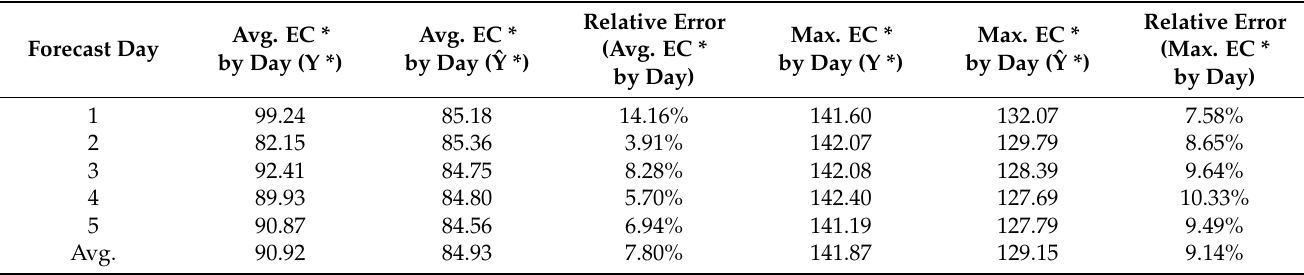
Table 10. Calculation of the relative error of the daily energy consumption (average and maximum) with respect to the testing-set (model: C3-T50).